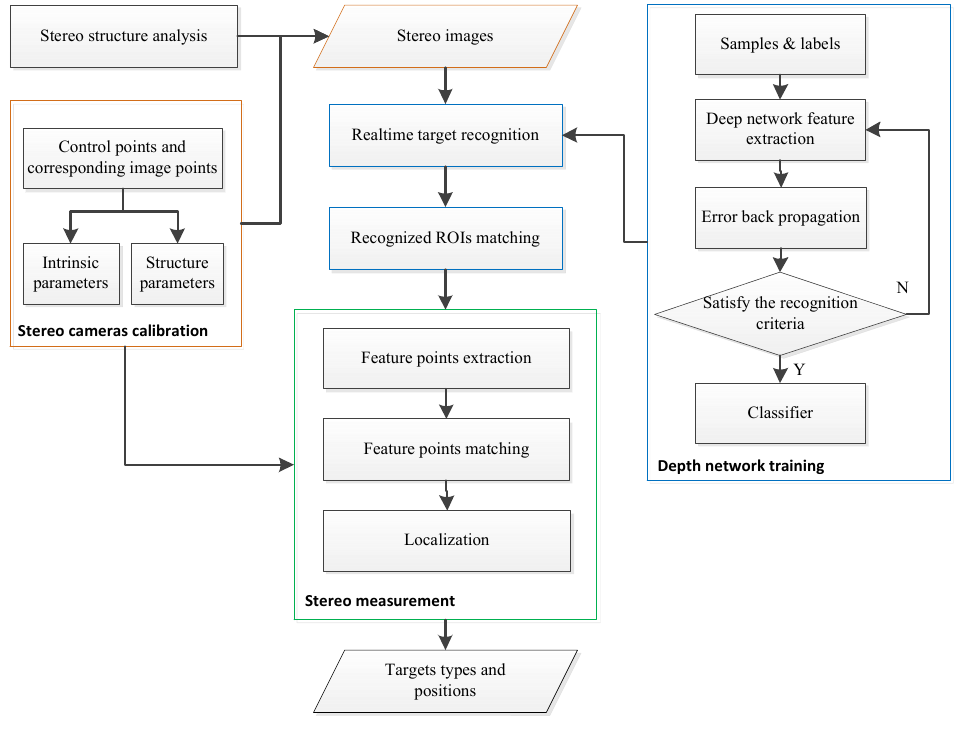
Figure 1. Flowchart of the proposed